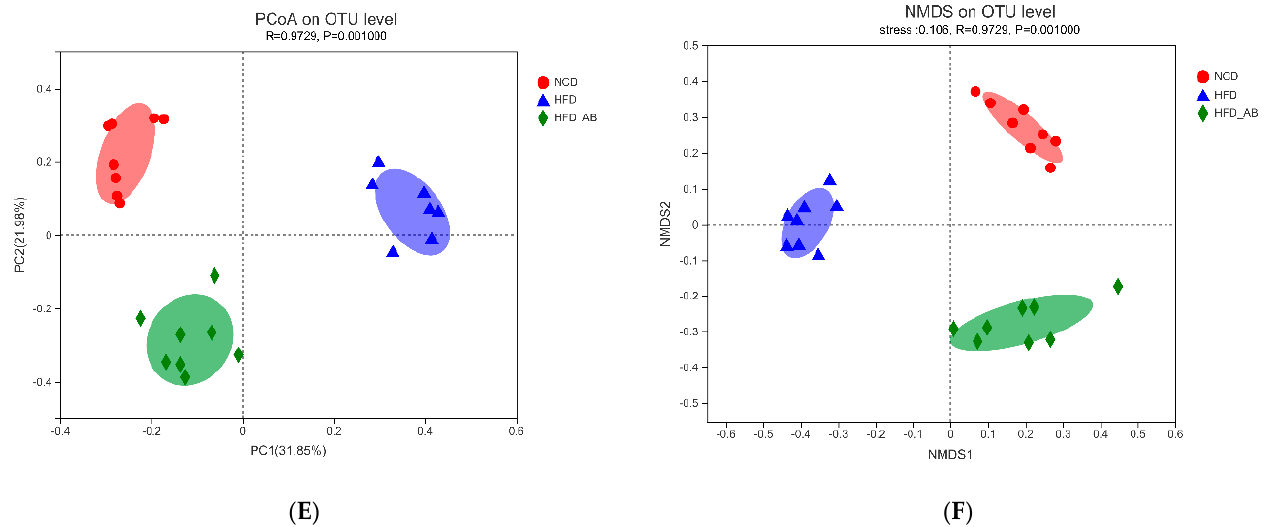
Figure 5. Effects of adzuki bean supplementation on the α and β diversity of gut microbiota in mice (n = 8 per group). ( A , B ) The community richness accessed by the ACE and Chao indices, ( C , D ) the community diversity accessed by the Shannon and Simpson indices, and ( E , F ) Principal coordinate analysis (PcoA) score plot and nonmetric multidimensional scaling (NMDS) score plot based on Bray–Curtis. # p < 0.05 and ## p < 0.01, HFD compared with NCD mice. ** p < 0.01, HFD-AB compared with HFD mice. NCD, normal control diet; HFD, high-fat diet; HFD-AB, high-fat diet supplemented with adzuki bean.